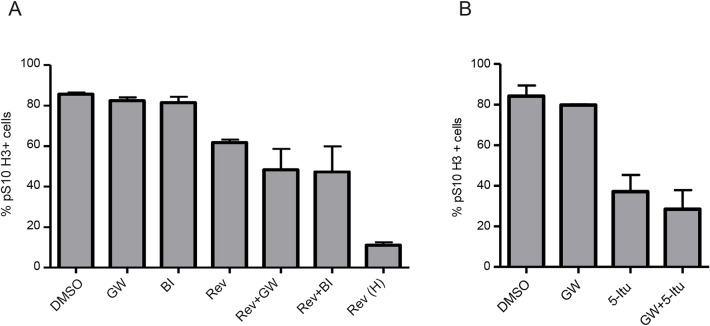
Effect of PLK1 inhibitors in combination with inhibitors of MPS1 or Haspin. Nocodazole-arrested cells were re-plated in the presence of nocodazole (A) with or without 1 μM GW843682X (GW), 100 nM BI 6727 (BI) or 100 nM Reversine (Rev), both GW843682X and 100 nM Reversine (Rev+GW), both BI 6727 and 100 nM Reversine (Rev+BI), or high dose (500 nM) Reversine [Rev (H)]. After 3 h cells were collected, stained and analysed by flow cytometry. 10,000 cells were counted for each treatment per repeat. Error bars are s.d., N=3. (B) Nocodazole-arrested cells were re-plated in the presence of nocodazole with or without 1 μM GW843682X (GW), 10 μm 5-Itu or both GW843682X and 5-Itu (GW+5-Itu). Cells were then stained and analysed as in A. Error bars are s.d., N=2.